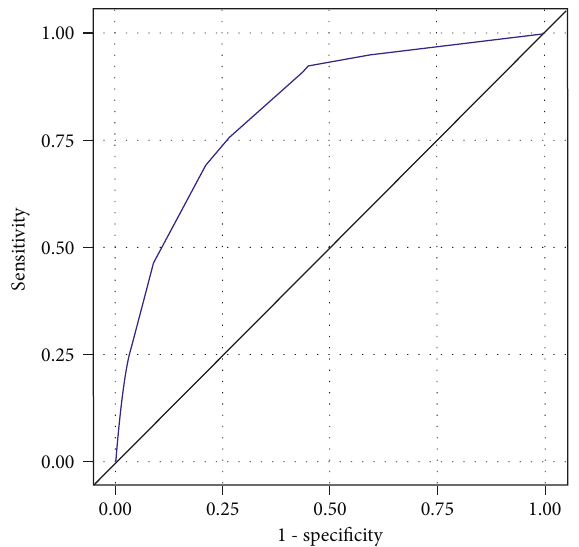
Figure 1: ROC curve for simplified multivariable model. This simplified multivariable model exhibited high discrimination (c- statistic 0.821, 95% CI: 0.783–0.859) using the area under the ROC curve. AUC � 0.821 (95% CI: